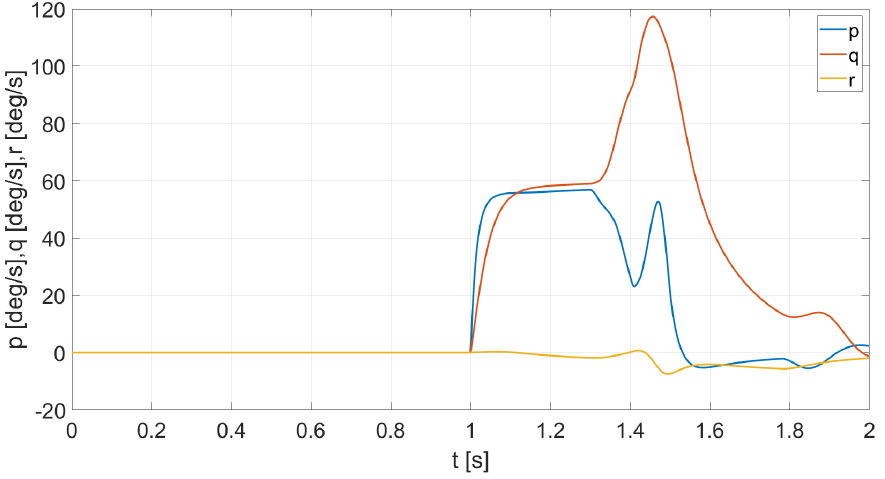
Figure 10. UAV angular speed response—PID-SDRE control mode, t f = 1